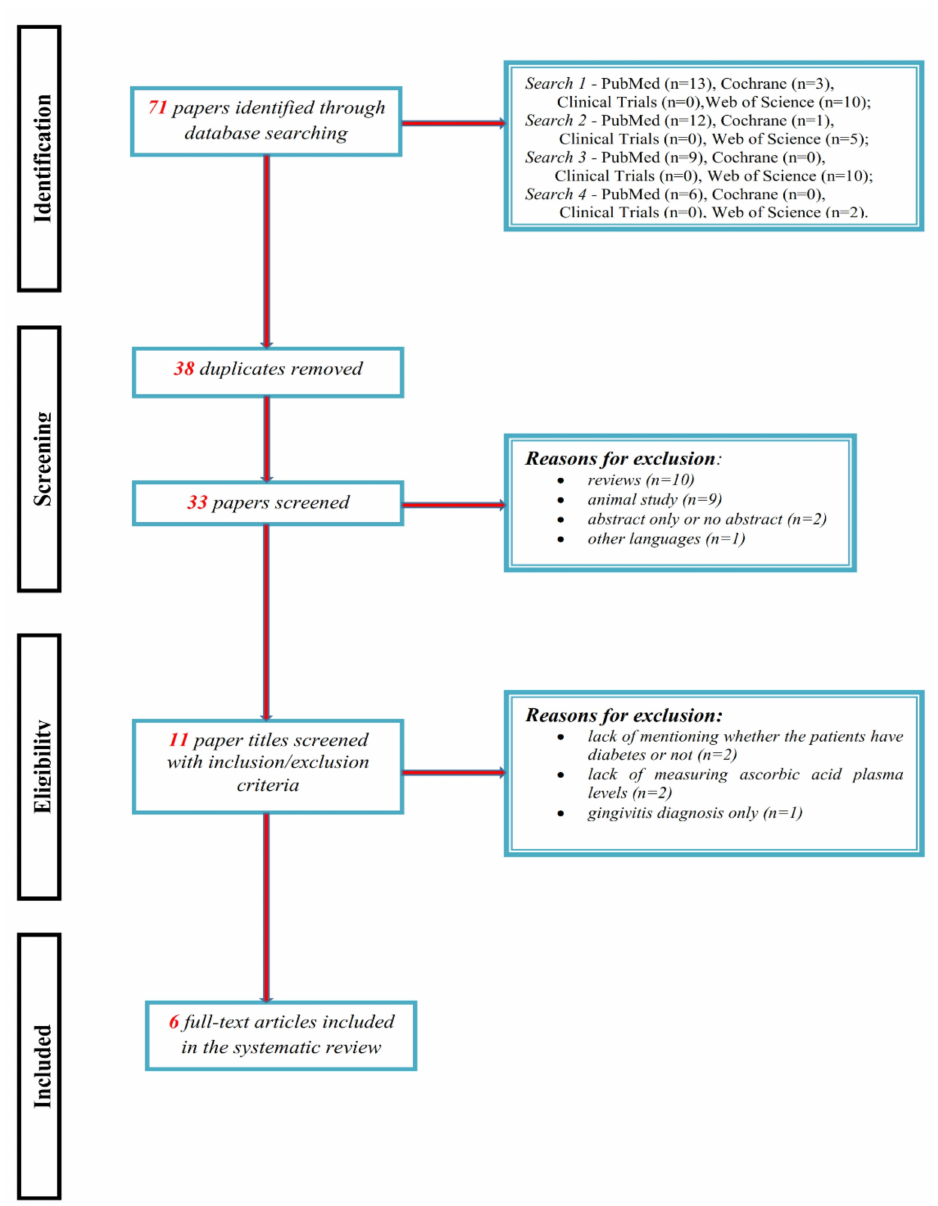
Figure 2. Flowchart of the systematic search based on PRISMA